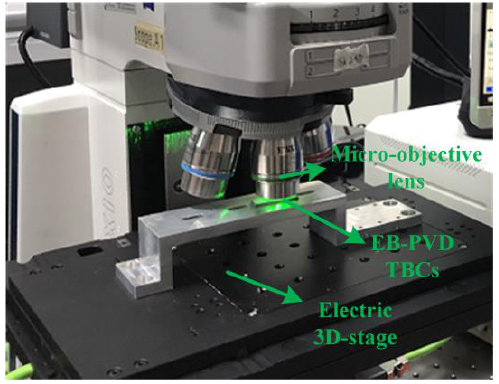
Figure 3. Schematic of the TGO stress characterization system.